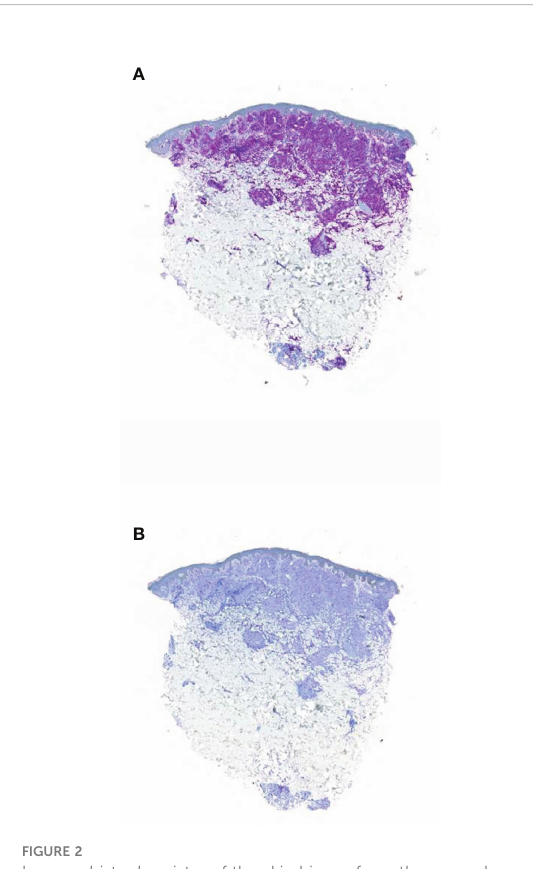
FIGURE 2 Immunohistochemistry of the skin biopsy from the second patient. (A) In fi ltration of small cellular lymphoid cell components in CD 8 staining; scale bar, 500 µm. (B) Antigen loss of CD2 of the lymphoid in fi ltrates detected in hematoxylin and eosin staining; scale bar, 500 µm.